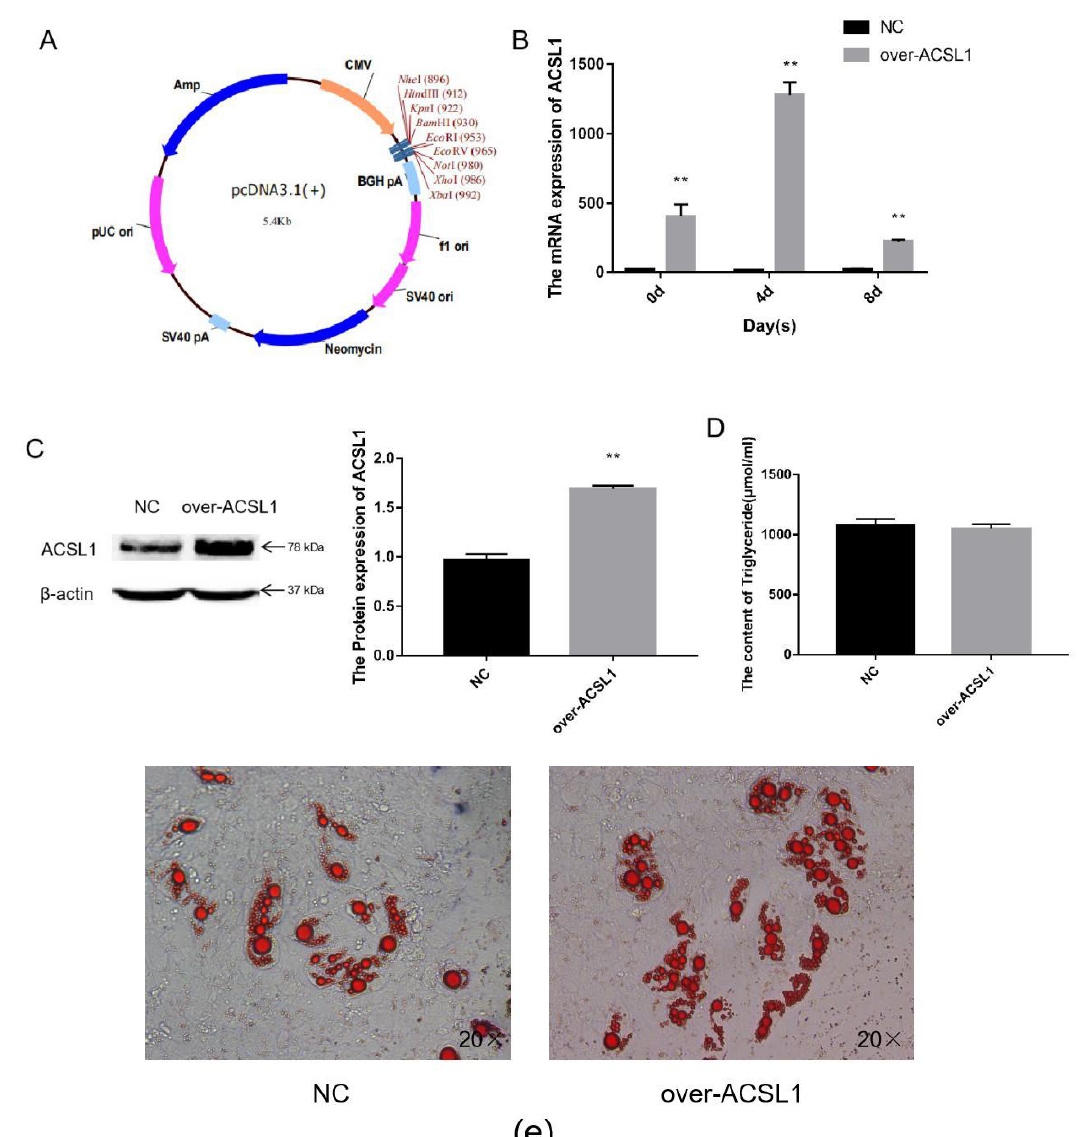
Figure 1. Overexpression of the ACSL1 gene in sheep preadipocytes: ( a ) the pcDNA3.1(+) vector; ( b ) mRNA expression of the ACSL1 gene on days 0, 4, and 8 of differentiation (* p < 0.05, ** p < 0.01); ( c ) the protein expression of the ACSL1 gene on day 8 of differentiation; ( d ) the detection of intracellular triglyceride content; ( e ) oil red staining of adipocytes after induced differentiation on day 8 (Left: control; Right: overexpression ACSL1). NC: Adipocytes transfected with pcDNA3.1(+) vector for control. Over-ACSL1: Adipocytes transfected with pcDNA3.1(+) vector with ACSL1 CDS.